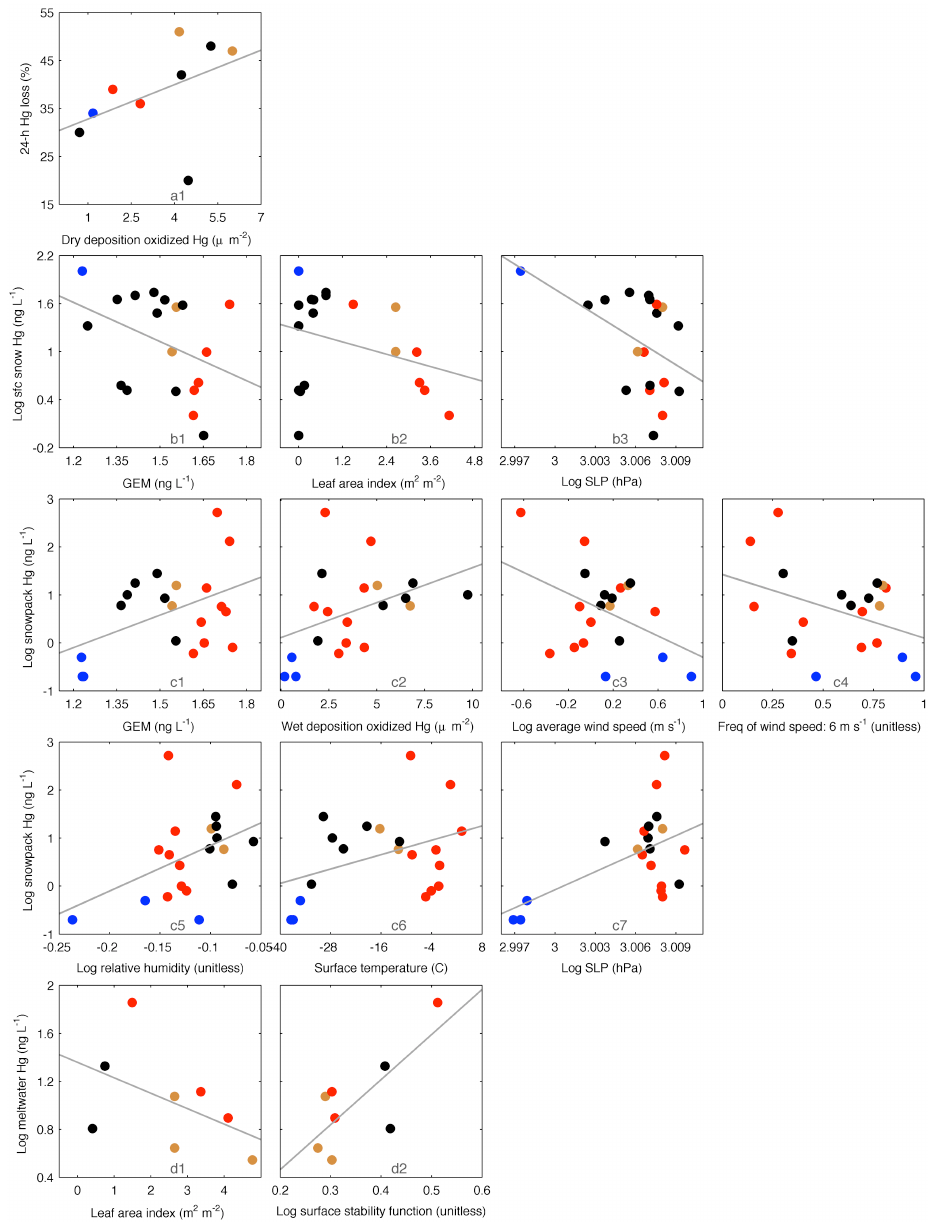
Fig. 2. Scatter plots of model environmental variables that are sufficiently strongly and significantly correlated with Set1: (a1) 24-h fractional loss of mercury from surface snow, and concentrations of mercury in (b1–b3) surface snow, (c1–c7) seasonal snowpacks, and (d1–d2) the snowpack meltwater’s ionic pulse. Blue, red, brown, and black circles represent observations from, respectively, Antarctica, midlatitudes, the subarctic and the Arctic. The grey line was estimated by the bivariate linear regression for Set1.